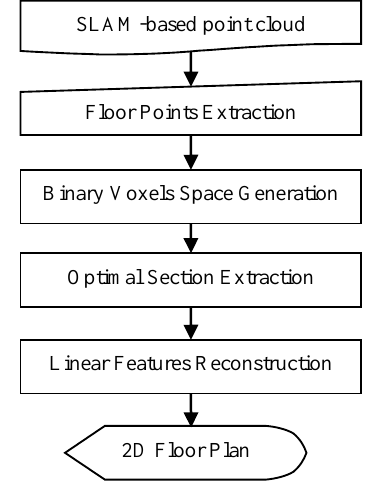
Figure 1. The workflow of the proposed